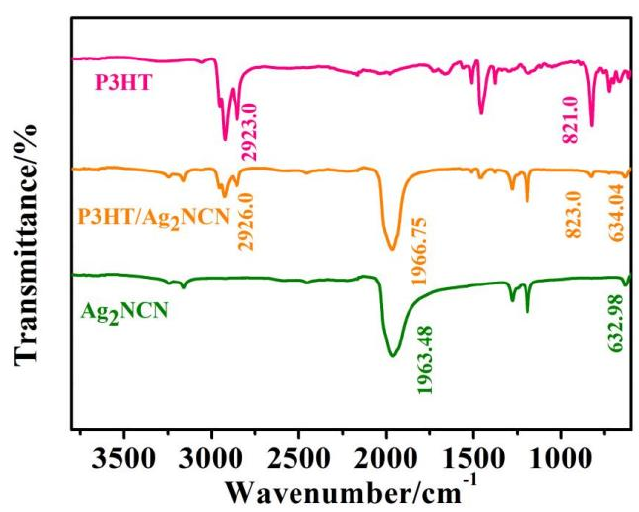
Figure 6. Infrared spectra of P3HT, Ag 2 NCN, and P3HT@Ag 2 NCN composite films.